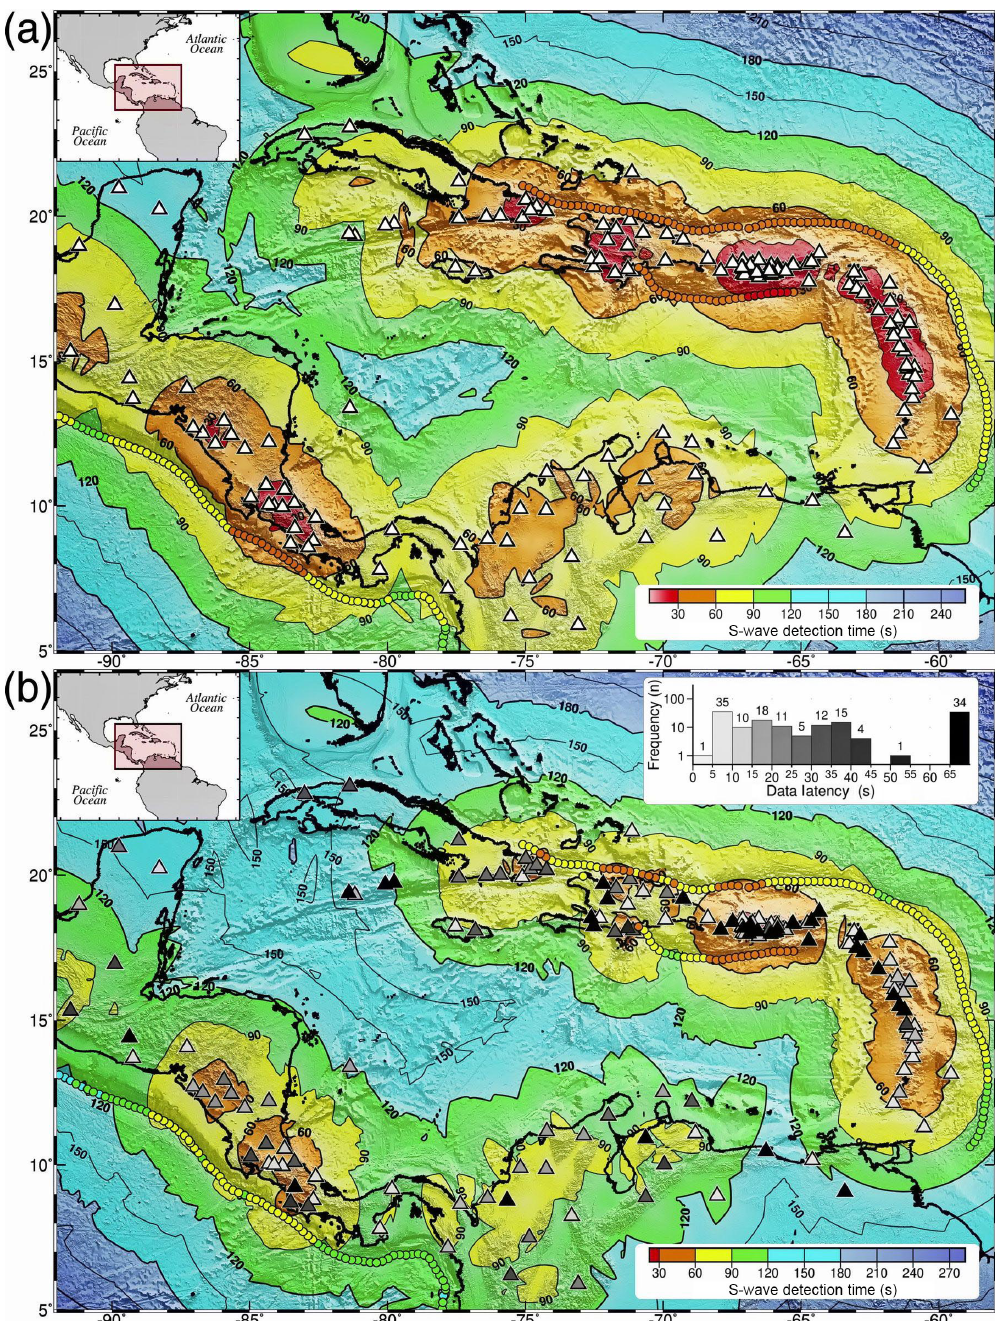
Figure 2. Theoretical detection time of the first arriving S wave within the Caribbean region at a minimum of five stations, regardless of azimuthal gap after (a) assuming that all seismic stations (white triangles) contribute data with no significant latencies and (b) taking into account the median data latencies and station outages. Station outages at 23% (34 black triangles) of the 146 seismic stations and data latencies longer than 10s for another 52% leave only 25% of the network with latencies under 10s. Consequently, the 90 (yellow), 60 (orange), and 30s (red) detection areas shrink from 47% to 23%, 18% to 6%, and 2.7% to 0.2% of the region, equivalent to a 51%, 66%, and 92% reduction in area, respectively. The small, contiguous circles show the computed S wave detection times sampled every 25km along the trench